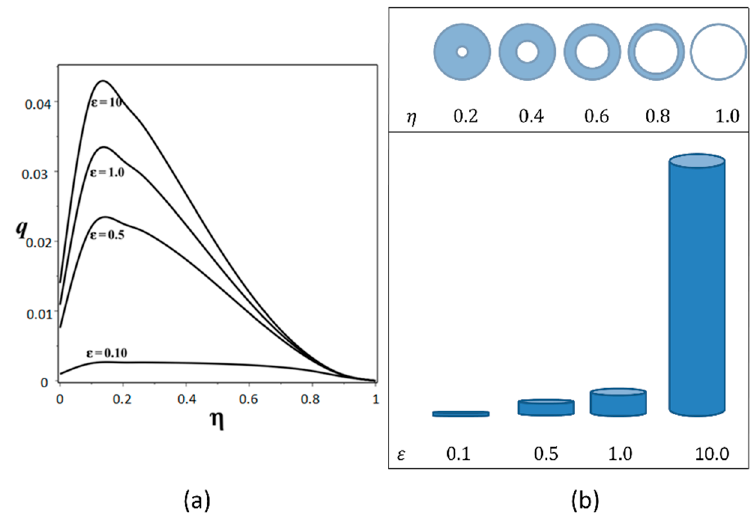
Figure 2. ( a ) 2D dimensionless flow rate q versus η for aspect ratio ε = 0.1, 0.5, 1.0, 10.0. ( b ) Physical representation of η and ε relation. Sensors 2018 , 18 , x FOR PEER REVIEW